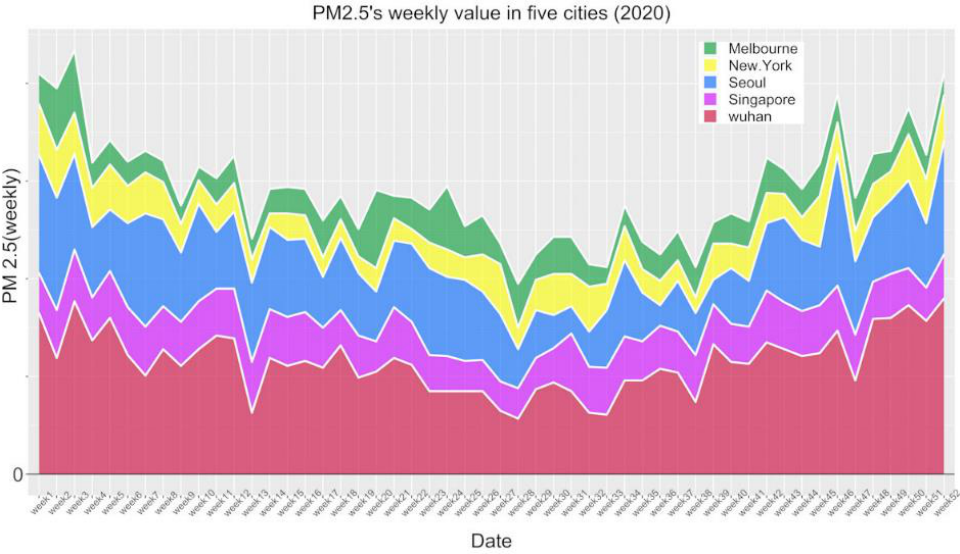
Figure 11. Weekly PM2.5 values in five cities in 2020 (area of each colour indicates the present week’s PM2.5 values).